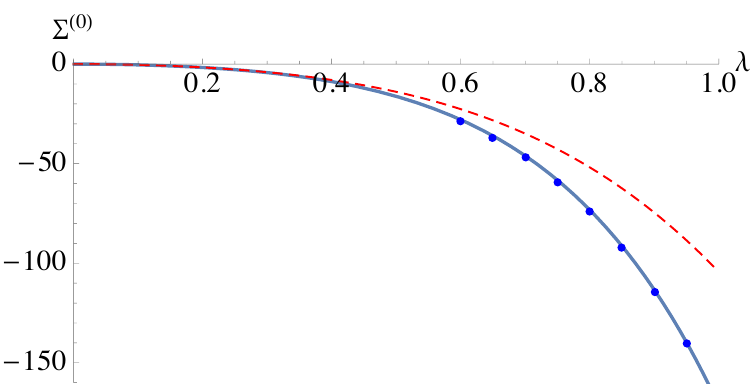
Figure 1 . Plot of the function Σ (0) in (F.16), i.e. the planar contribution to h W 2 i conn (blue line). The red thin dashed line represents the contribution of the first two terms of the weak coupling expansion (F.8). The blue dots represent the leading term in the strong coupling expansion √ 2 λ 0 , where λ 0 = λ − 1 − 1 e 2 π . The agreement is very good already at the moderate values √ 24 8 π 2 λ 0 of the coupling λ ∼ 1